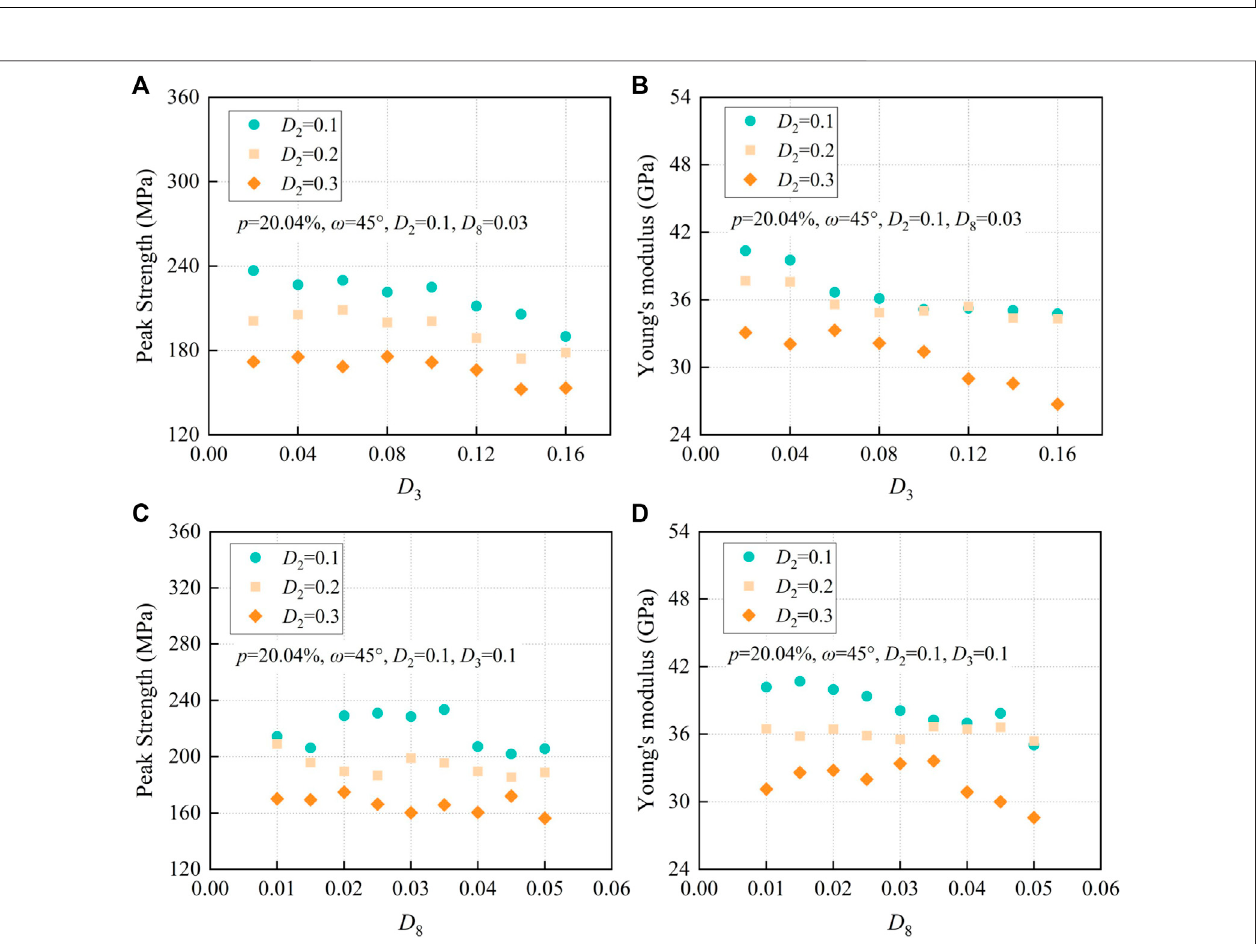
FIGURE12| Resultsof (A) compressivepeakstrengthforgroupD3-D2; (B) correspondingYoung ’ smodulusforgroupD3-D2; (C) compressivepeakstrengthfor group D8-D2; and (D) corresponding Young ’ s modulus for group D8-D2.